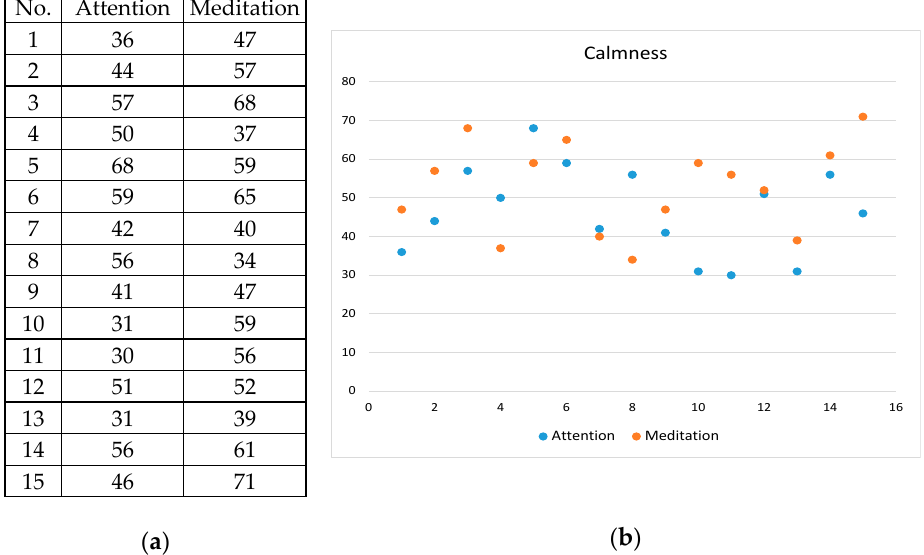
Figure A3. The data and the distribution graph of the average values of the 15 measured two-feature sample sequences of the emotion type of calmness, from which the corresponding decision rule 30 ≤ a < 70 and 30 ≤ m < 70 for emotion classification was inferred, where m and a represent the meditation and attention signals, respectively. ( a ) The average data. ( b ) The distribution graph.